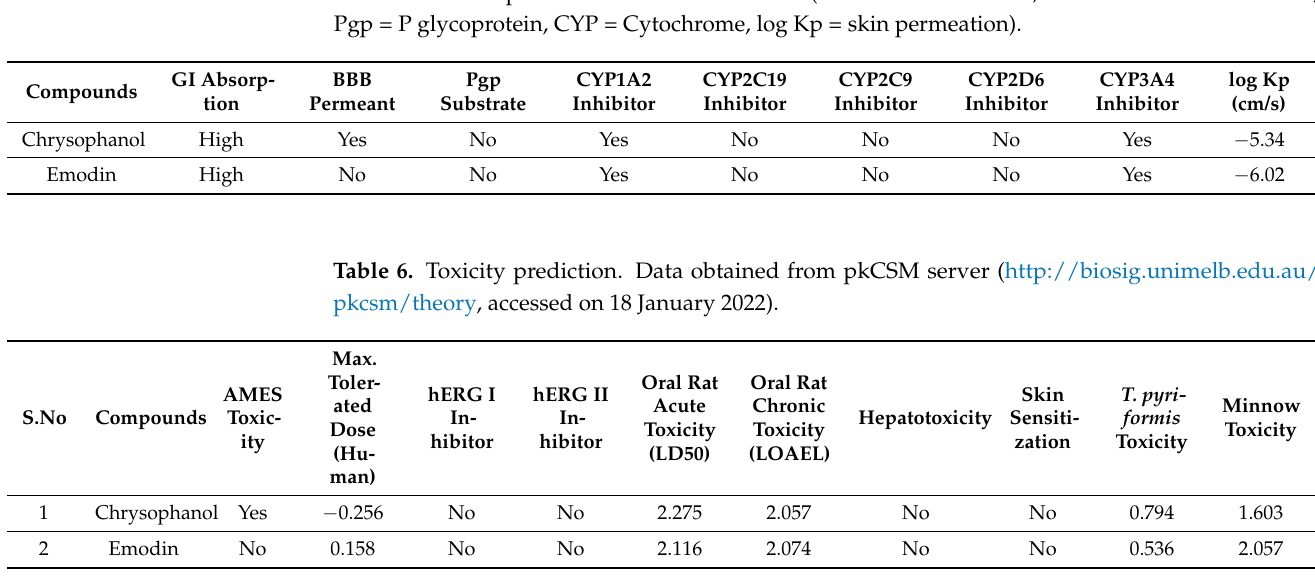
Table 5. ADME prediction from SwissADME (GI = Gastrointestinal, BBB = Blood-brain barrier,